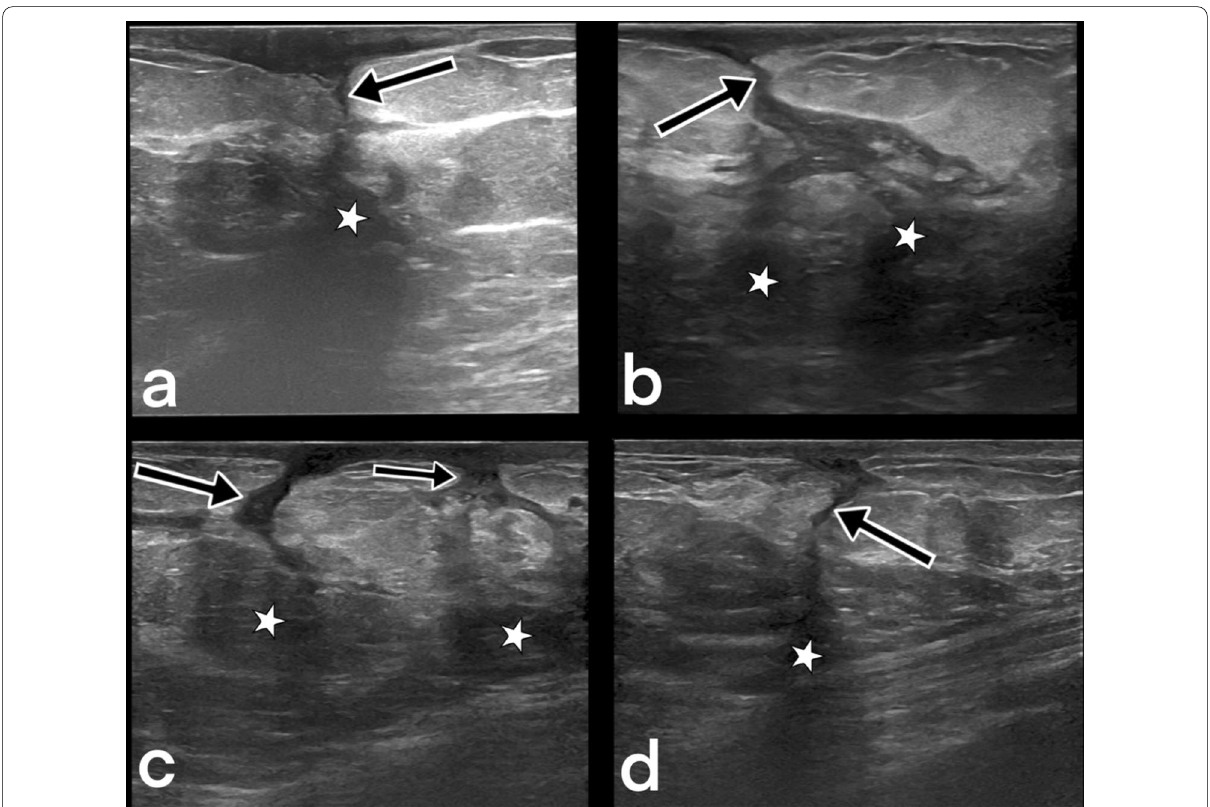
Fig. 9 Ultrasound images from four different female patients ( a – d ). Sinus tracts (arrows) and related abscess formations (stars). BIRADS